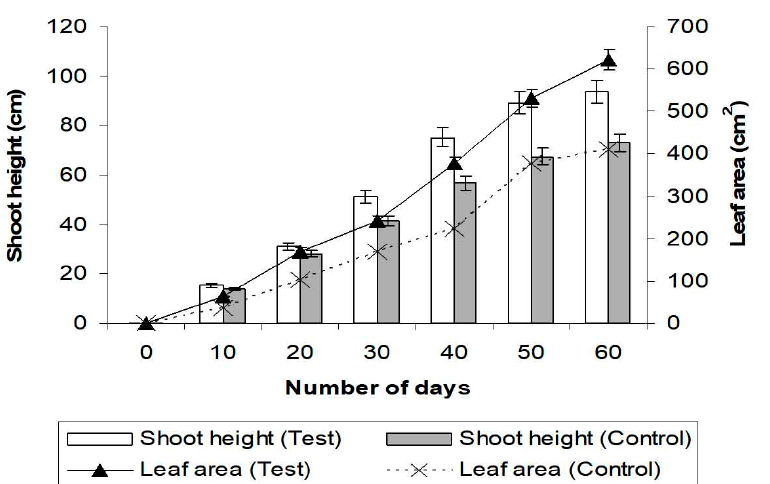
Fig. 3 . Comparative analysis of shoot length and leaf area of Abelmoschus esculentus plant in both biofertilizer inoculated and un-inoculated Table 3. Comparative morphological analysis of Abelmoschus esculentus plant in both biofertilizer inoculated and un-inoculated pots